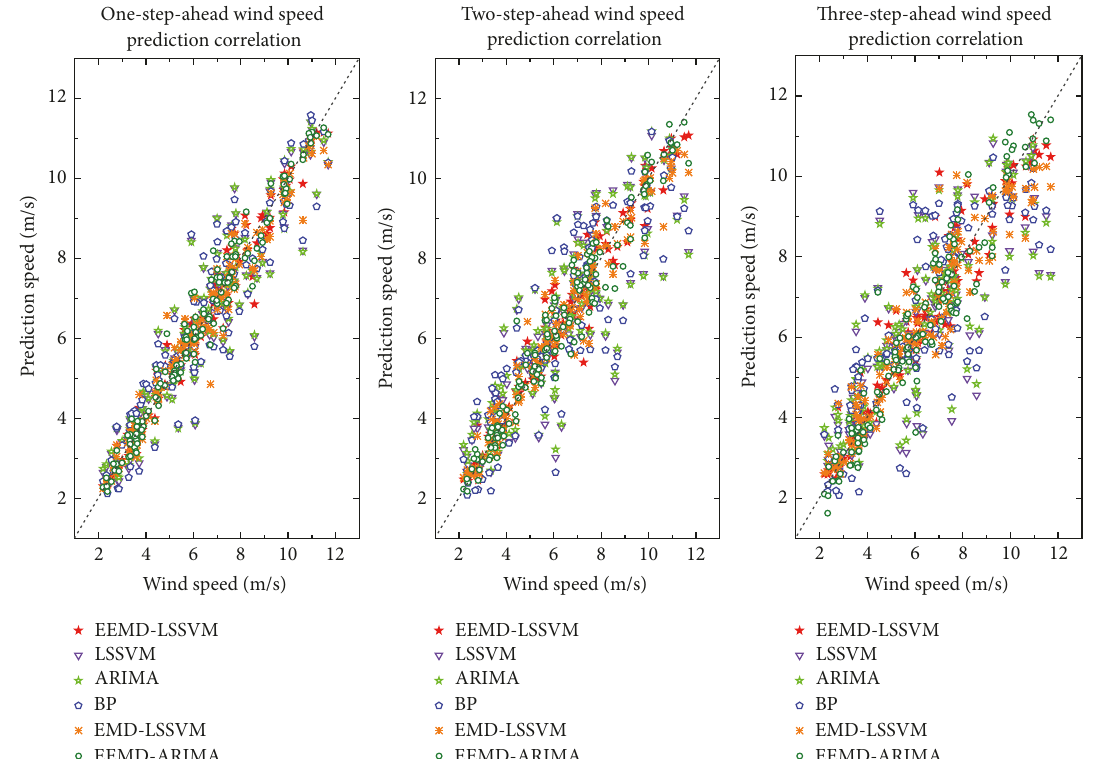
Figure 9: Scatter plots of prediction versus actual wind speed for different models (Case